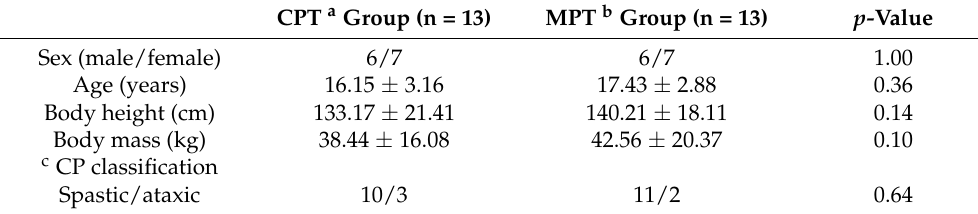
Table 1. Demographic and clinical characteristics of patients.